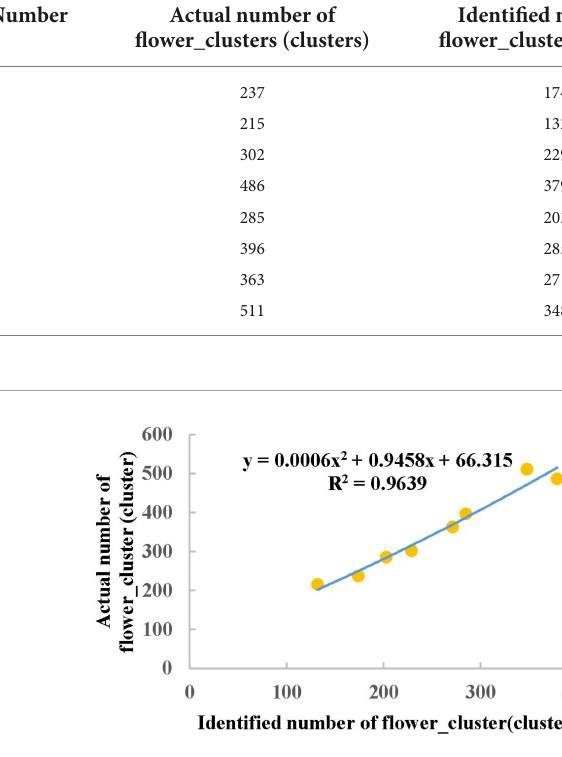
the freezing and unfreezing stages and the batch size is 2 in the unfreezing state, the mAP of the model is